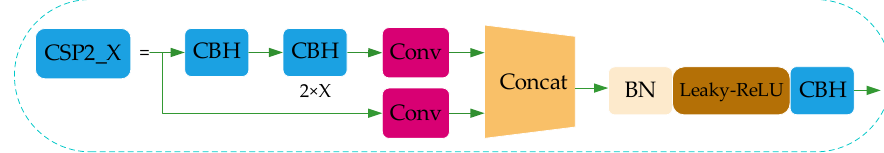
Figure 5. CSP 2 _X module